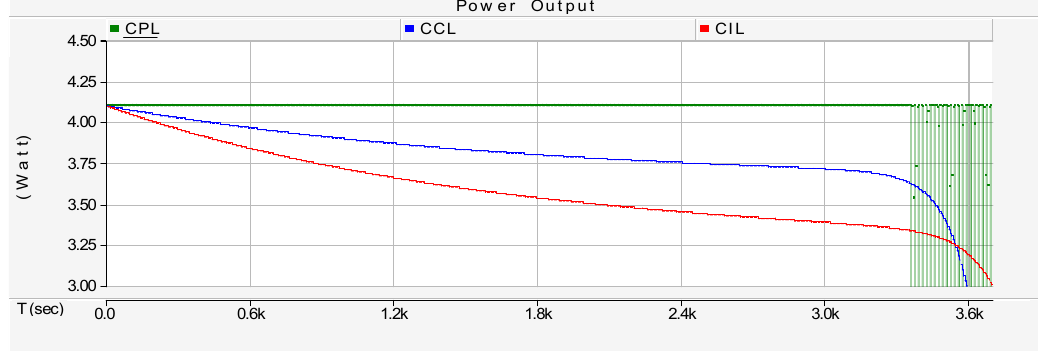
Figure 15. Change in internal resistance with the decrease in SOC (left to right).